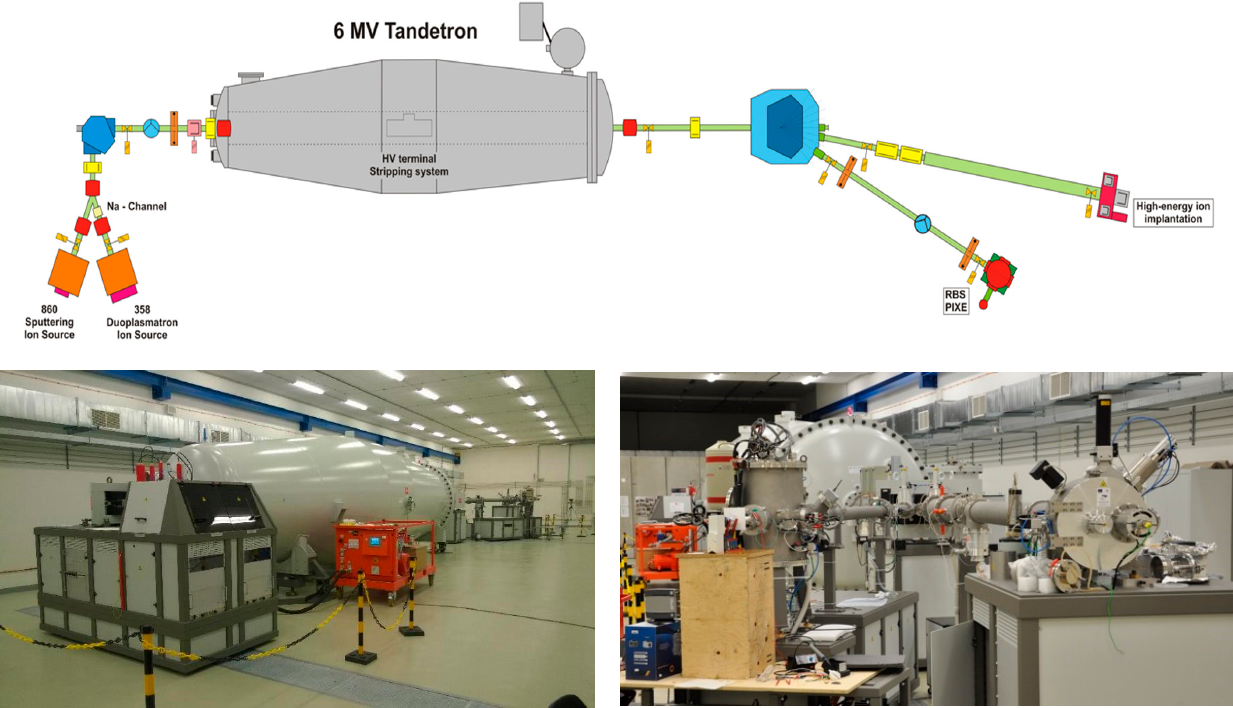
Figure 2. The 6 MV Tandetron ion accelerator at the Advanced Technologies Research Institute, Slovak University of Technology.